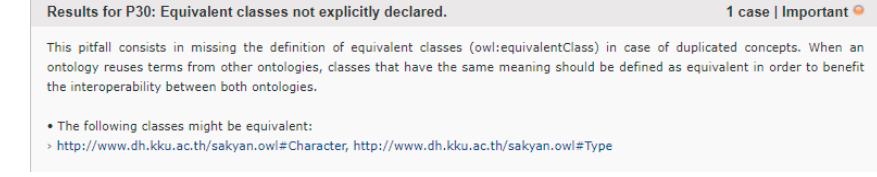
Figure 9. Equivalent classes not explicitly declared.